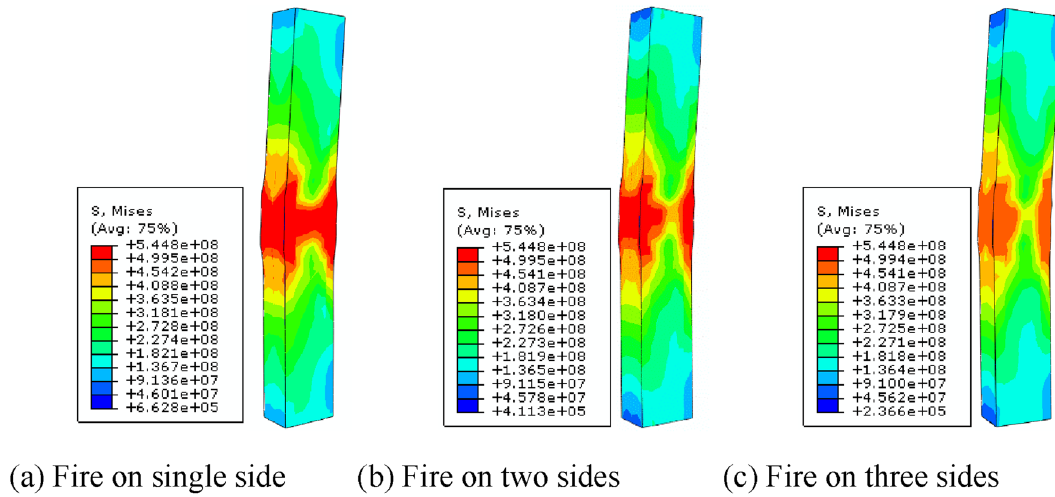
Figure 12. Failure mode of SRCFST members after reciprocal loading under non-uniform fire.